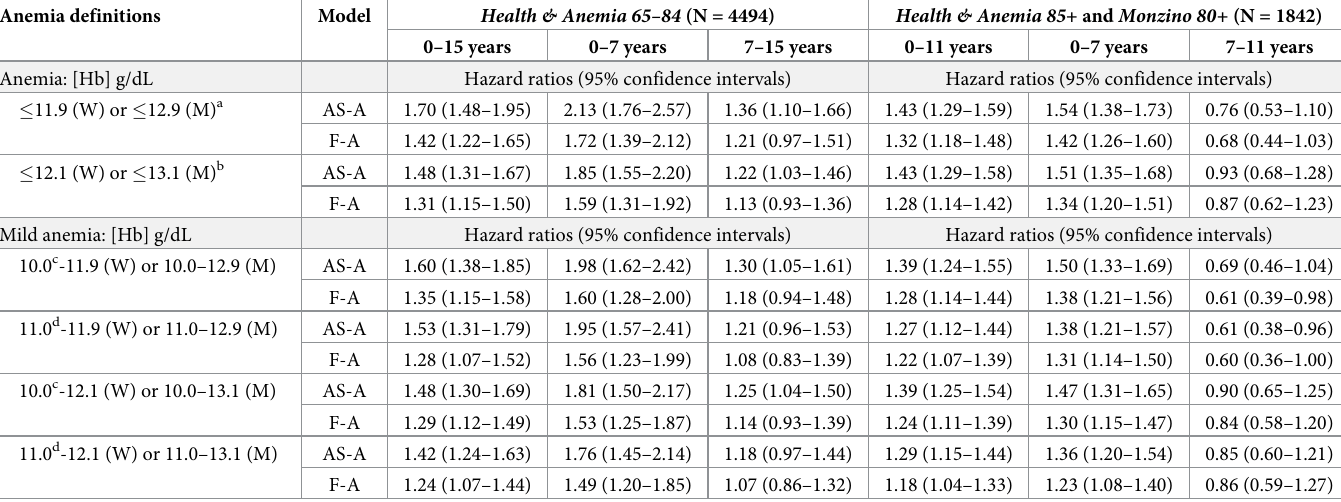
Table 2. Risk of mortality in anemic and mild anemic compared with non-anemic participants aged 65–84 years at blood sample from the Health and Anemia 65– 84 population-based study and participants aged 80 years or older at blood sample from two pooled population-based studies (Health and Anemia 85+ and Mon- zino 80-plus).